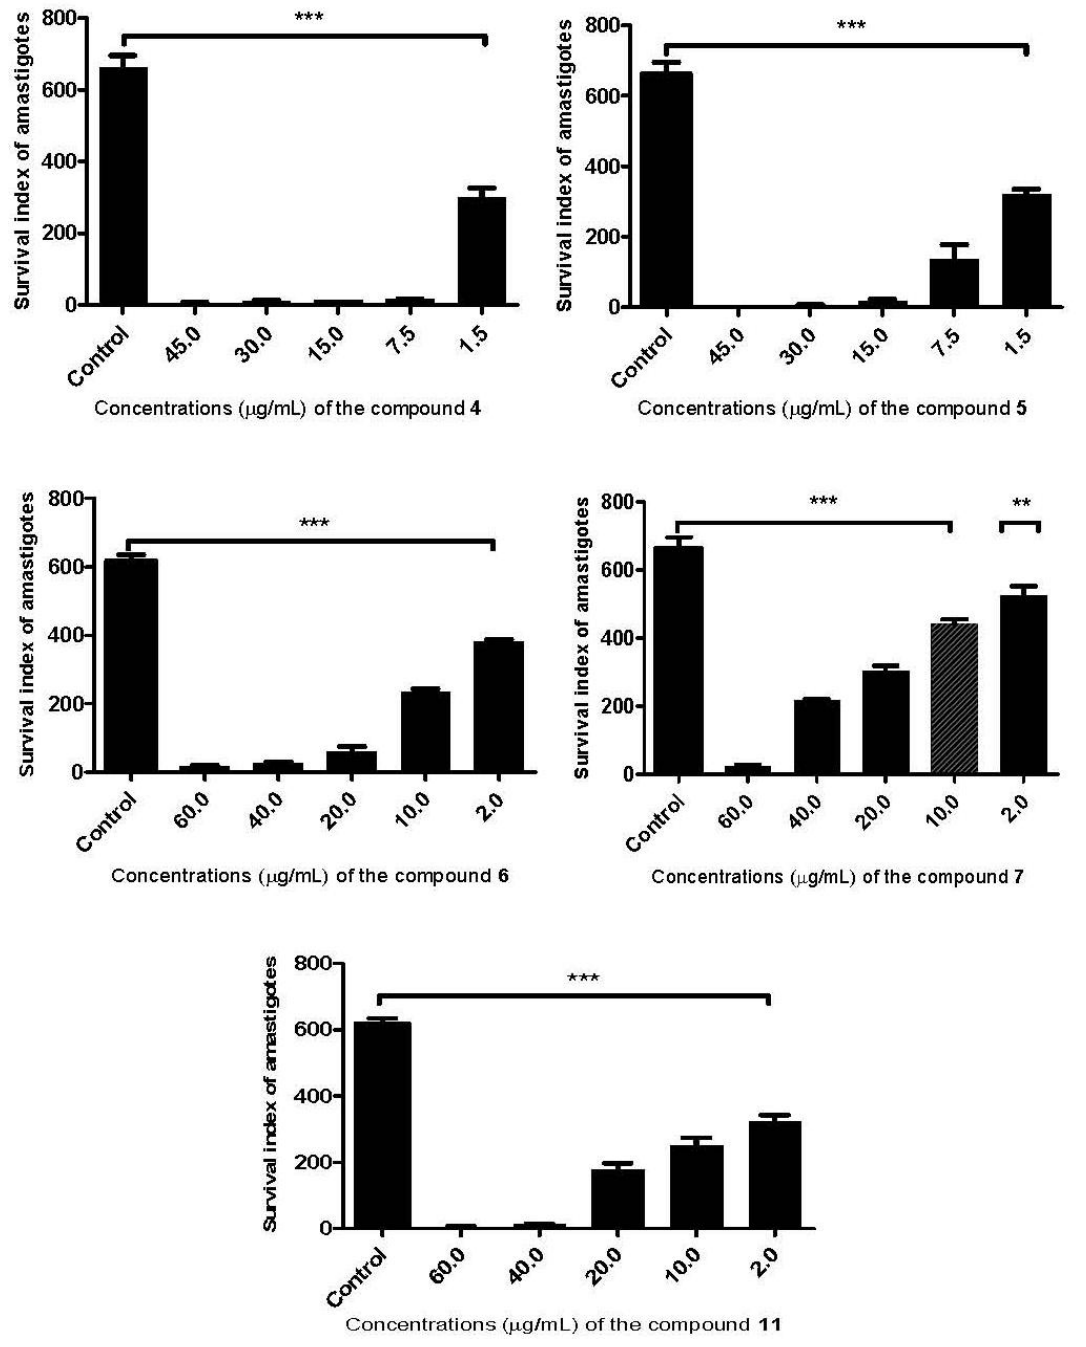
FIGURE 1. Effect of the imidazolidine derivatives on L. amazonensis interiorized in peritoneal macrophage cells. Statistically significant difference of control: ** p < 0.001; *** p <